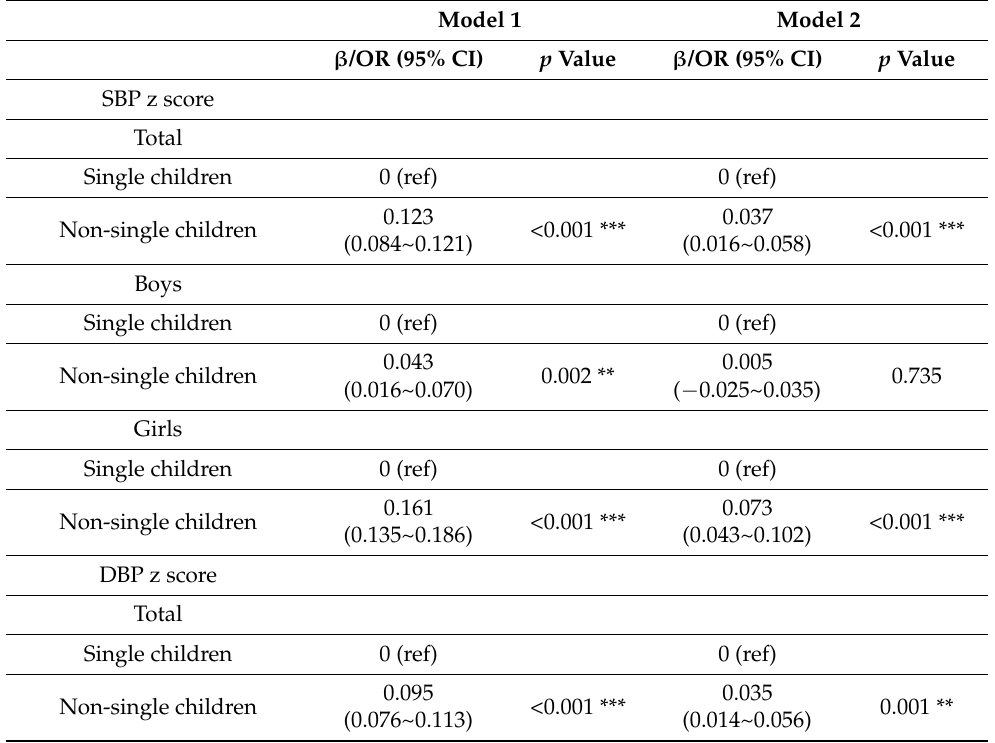
Table 2. Associations between single-child status and childhood